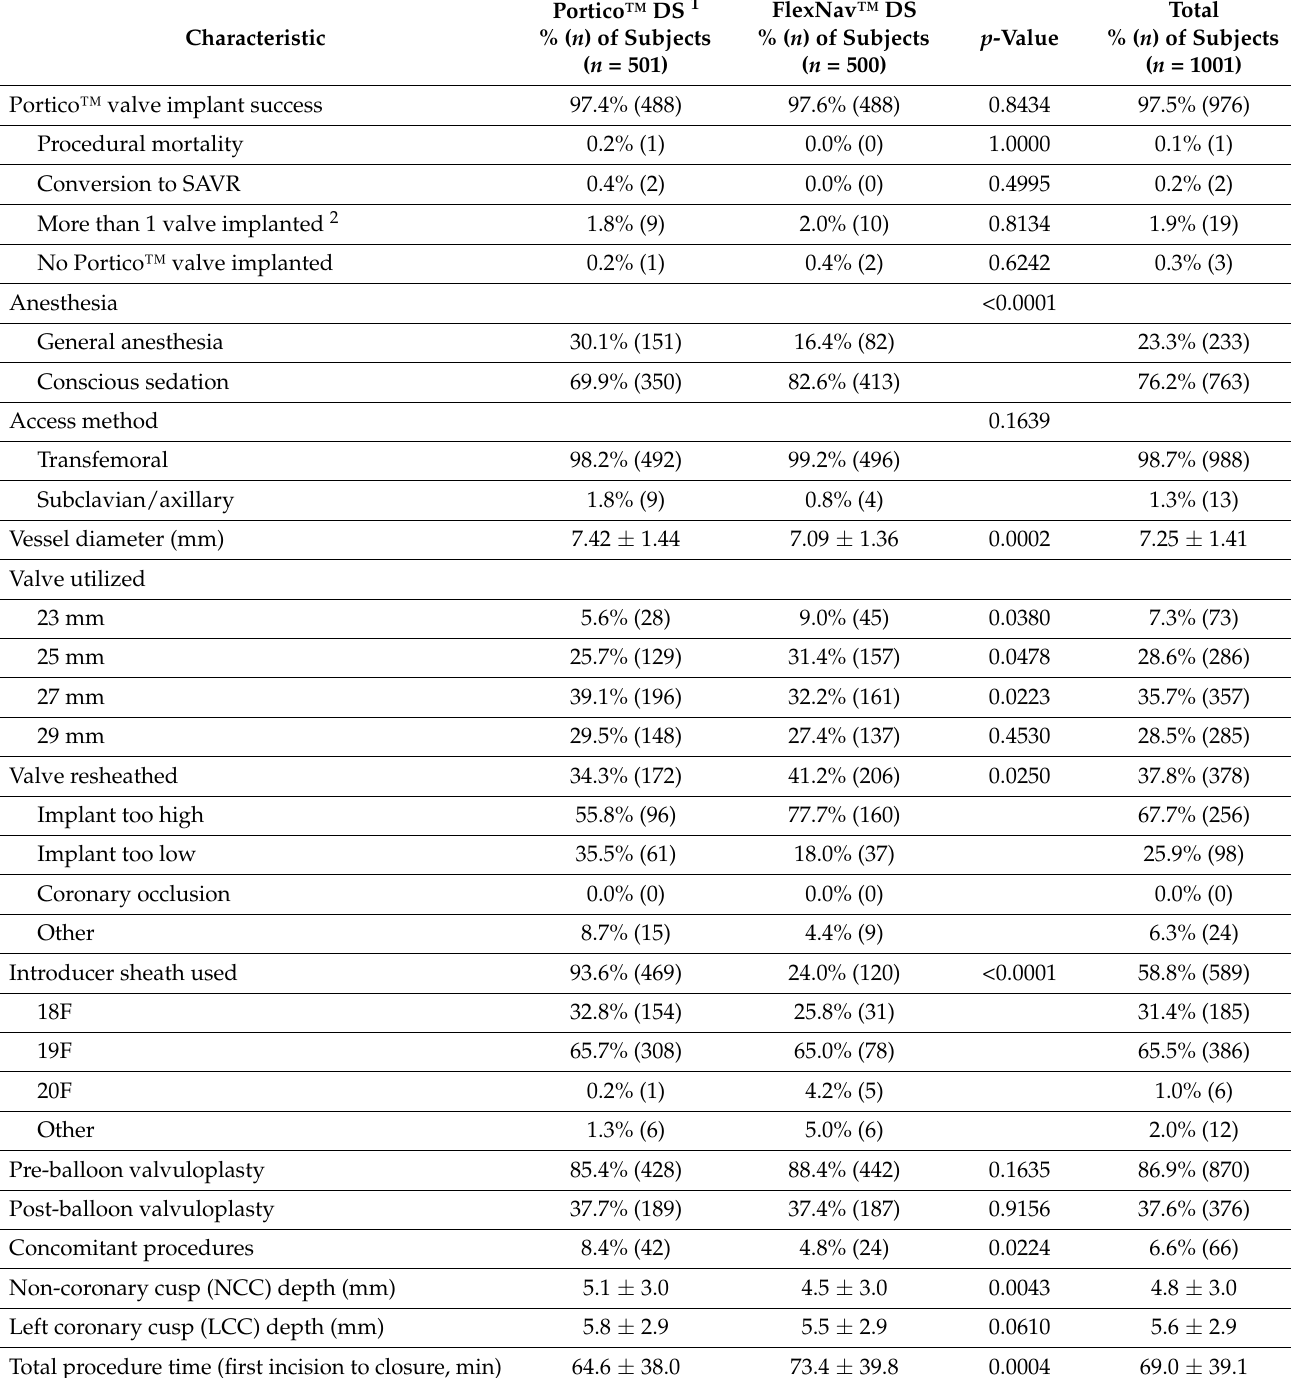
Table 2. Procedural